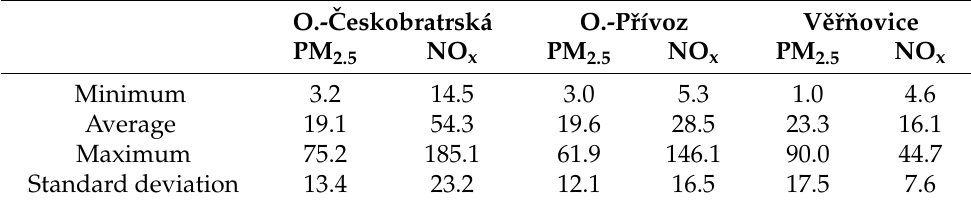
Table 2. Statistical summary of the PM 2.5 and NO x daily averages ( µ g/m 3